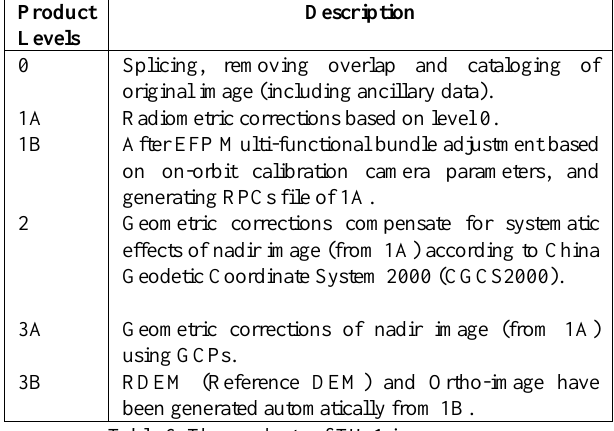
Table 6. The products of TH-1